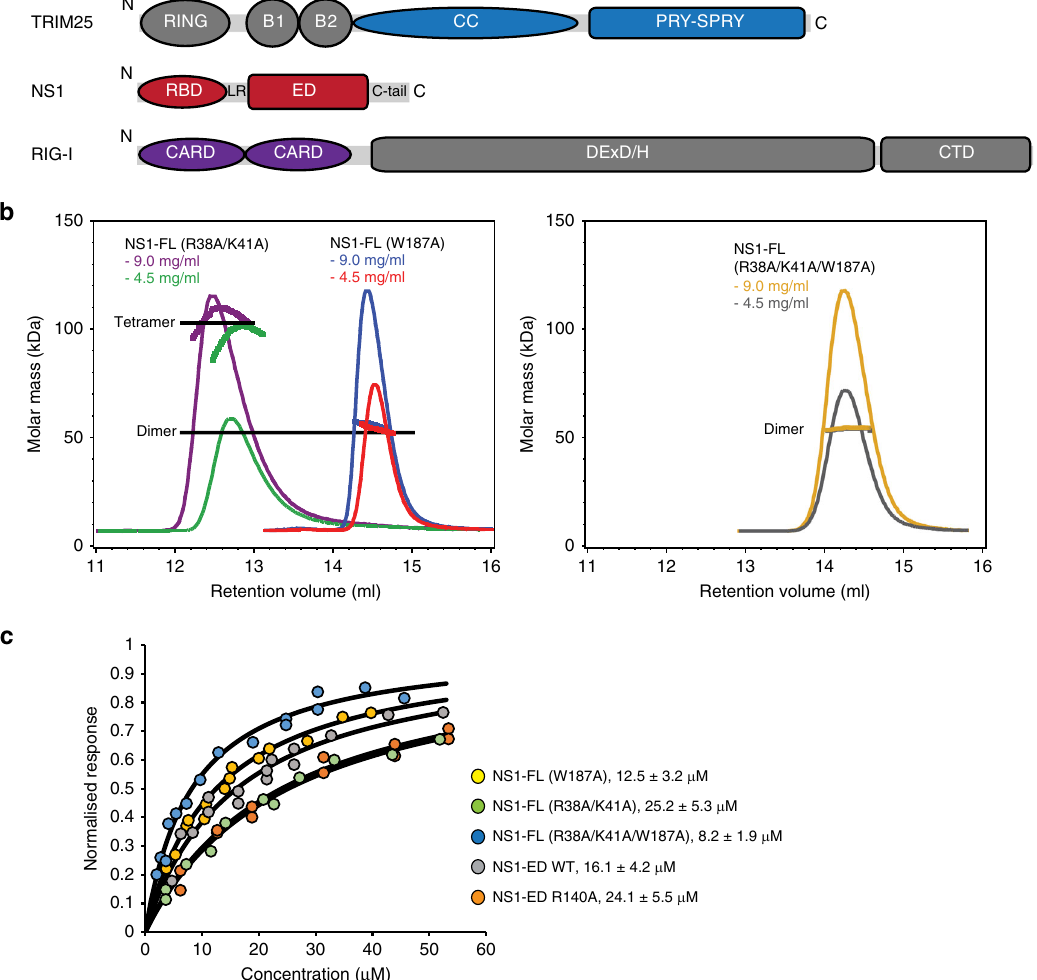
Fig. 1 Oligomeric state of NS1 and identi fi cation of TRIM25-interacting domains. a Schematic representation of TRIM25, NS1 and RIG-I domain structures. The crystallised TRIM25 CC-PRYSPRY domain is highlighted in blue and the crystallised RBD and NS1 domains of NS1 in red. The tandem CARD construct of RIG-I used in substrate ubiquitination assays is highlighted in purple. b The effect of different mutations on the oligomeric state of NS1-FL assessed by SEC – MALLS. The traces are colour coded according to the NS1 mutant and concentration used. c Quanti fi cation of the TRIM25-CC interaction with NS1 by biolayer interferometry (BLI). The binding curves are colour-coded and K d s determined are listed. The error is the standard deviation (s.d.) of mean from